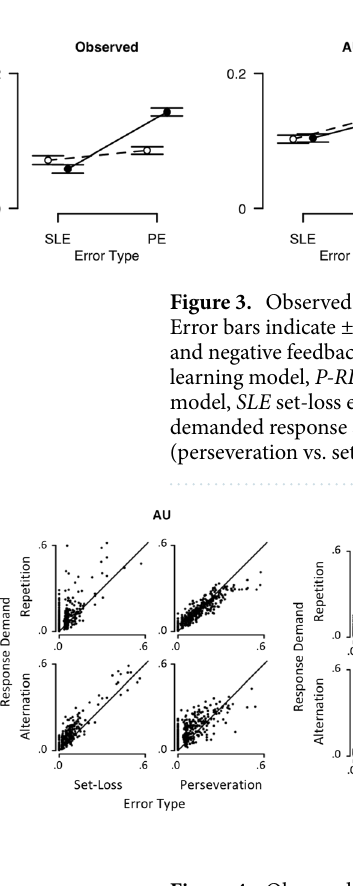
Figure 4. Observed ( x -axis) and simulated ( y -axis) individual conditional error probabilities. Note that set-loss and perseveration errors follow positive and negative feedback, respectively. AU attentional-updating model, MB-RL only model-based reinforcement-learning model, P-RL parallel reinforcement-learning model, wP-RL weighted parallel reinforcement-learning model, Conditional error probability probability of an error given error type (perseveration vs. set-loss) and response demand (repetition vs. alternation).